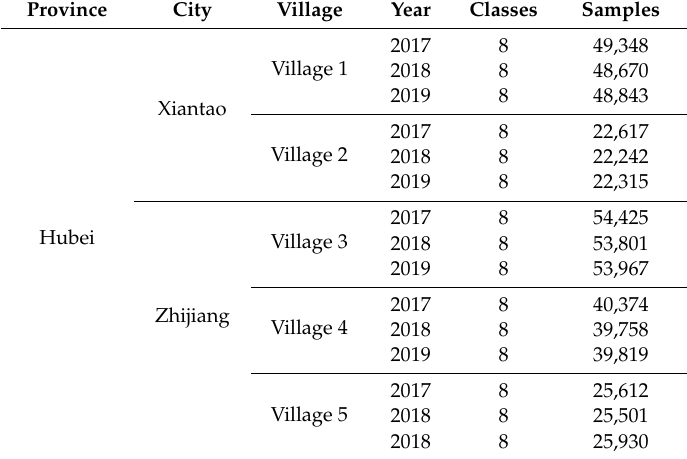
Table 4. The dataset from 2017 to 2019 in Hubei province, illustrated by two cities and five villages, with seven phenological stages.